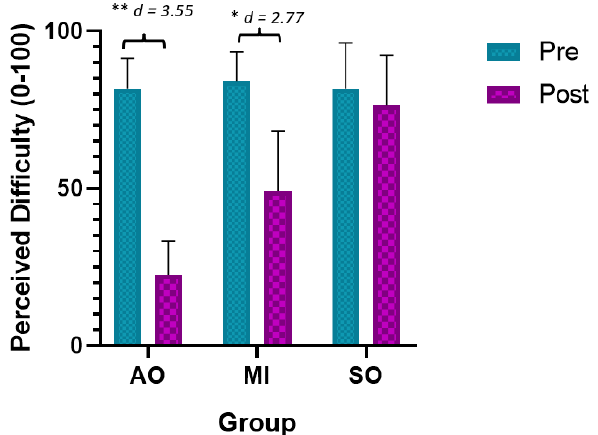
Figure 5. Main results for perceived difficulty. * p < 0.05; ** p < 0.01; MIP: motor imagery practice; AOP: action observation practice; SO: Sham observation .